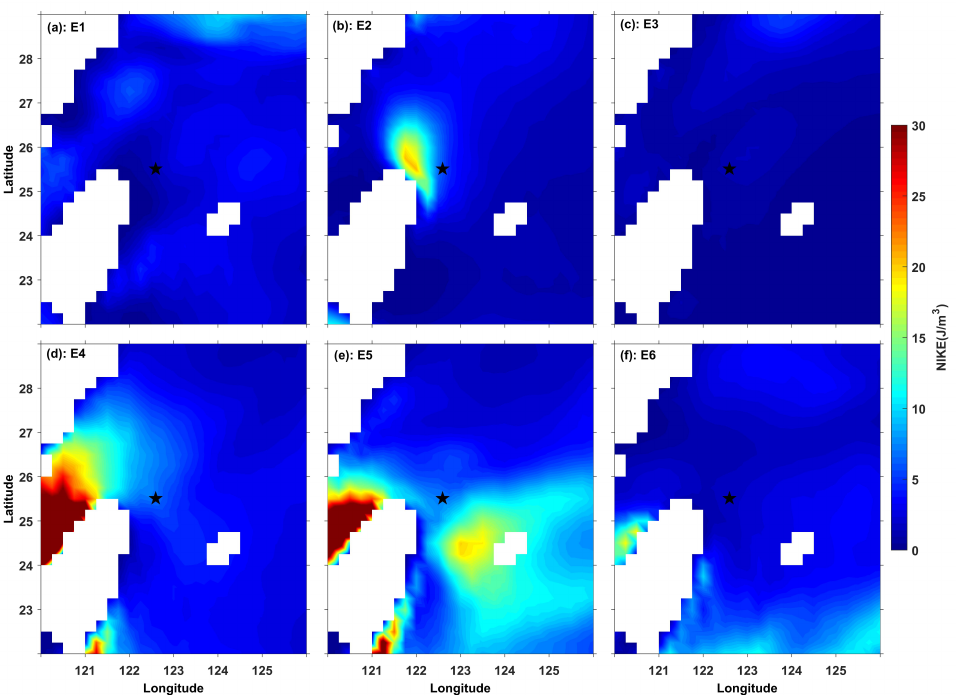
Figure 7. Time-averaged NIKE in the mixed layer one day before each NIWs episode obtained from the slab model with damping coefficient r = 0.25f and mixed layer depth calculated from the HYCOM data. Figures ( a – f ) correspond to episode 1 to 6,